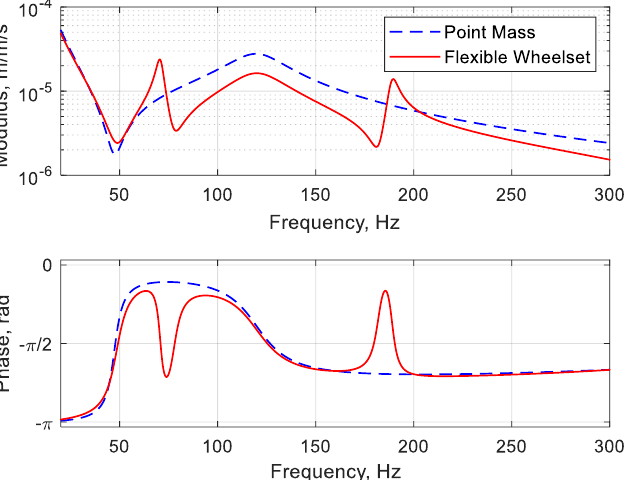
Figure 9. Transfer functions of the axlebox acceleration measurement system, derived with point mass and flexible wheelset models.